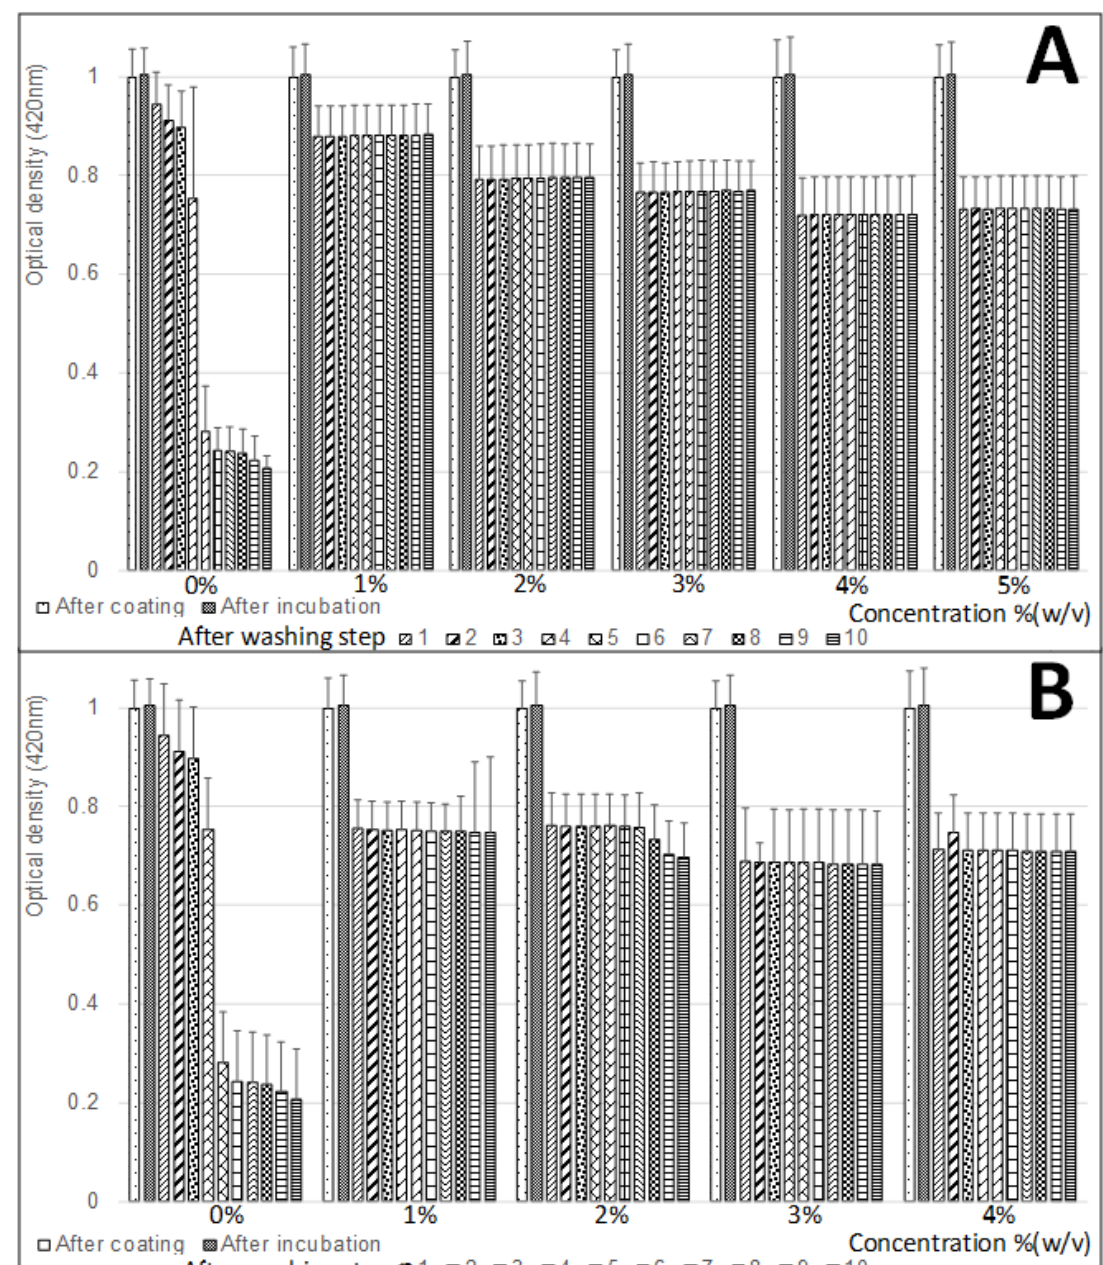
Figure 4. Effect of blocking treatment on the silver-layer stability. The influence of two blocking agents (( A ) skim milk and ( B ) bovine serum albumin (BSA)) on the silver-layer stability was examined.